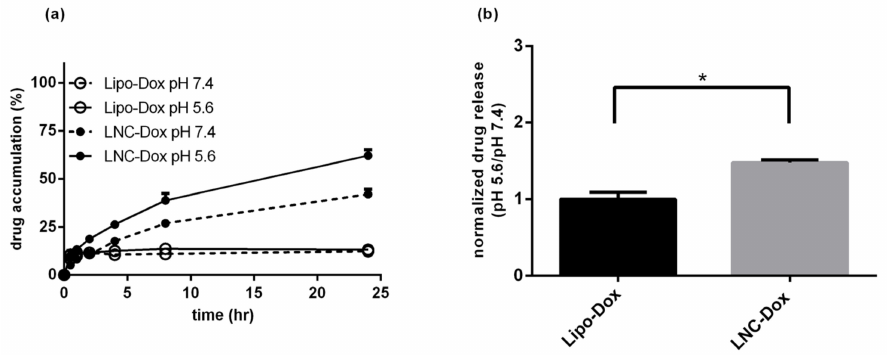
Figure 4. ( a ) In vitro drug release profiles of LNC-Dox and Lipo-Dox were performed in PBS (pH 7.4) and citrate buffer (pH 5.6) over a time period of 24 h. ( b ) The normalized drug release of LNC-Dox and Lipo-Dox (* p < 0.001). Data are expressed as the mean ± SD ( n =